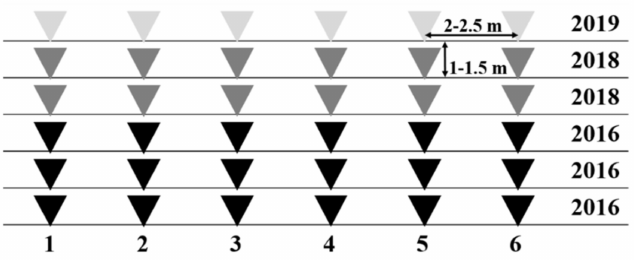
Figure 1. Diagram of sampling points (pyramid marks) in different years of plantation